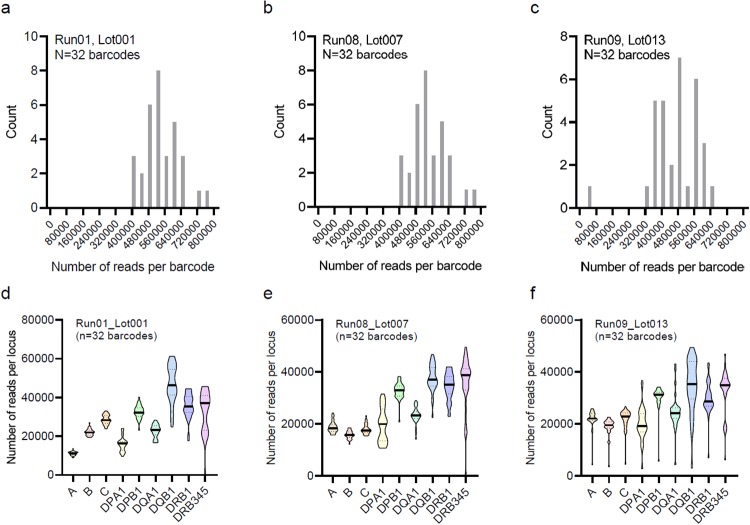
Distribution of the number of reads per sample and per locus.The histogram of read count per sample was plotted for three independent runs performed with three different lots of AllType reagents: a) Run01, Lot001. b) Run08, Lot007. c) Run09, Lot013. The number of reads per locus was also summarized for these runs: d) Run01, Lot001. e) Run08, Lot007. f) Run09, Lot013. Each run included 32 barcoded samples. Median (solid line) and interquartile (dotted line) are shown in the violin plots (d-f).